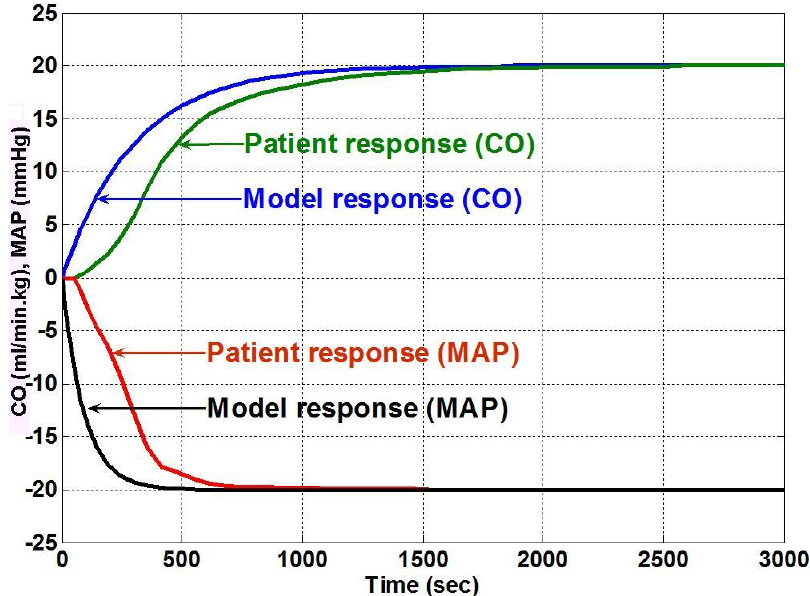
Figure 4: Patient response (CO and MAP) without disturbance, when K 22 = -15